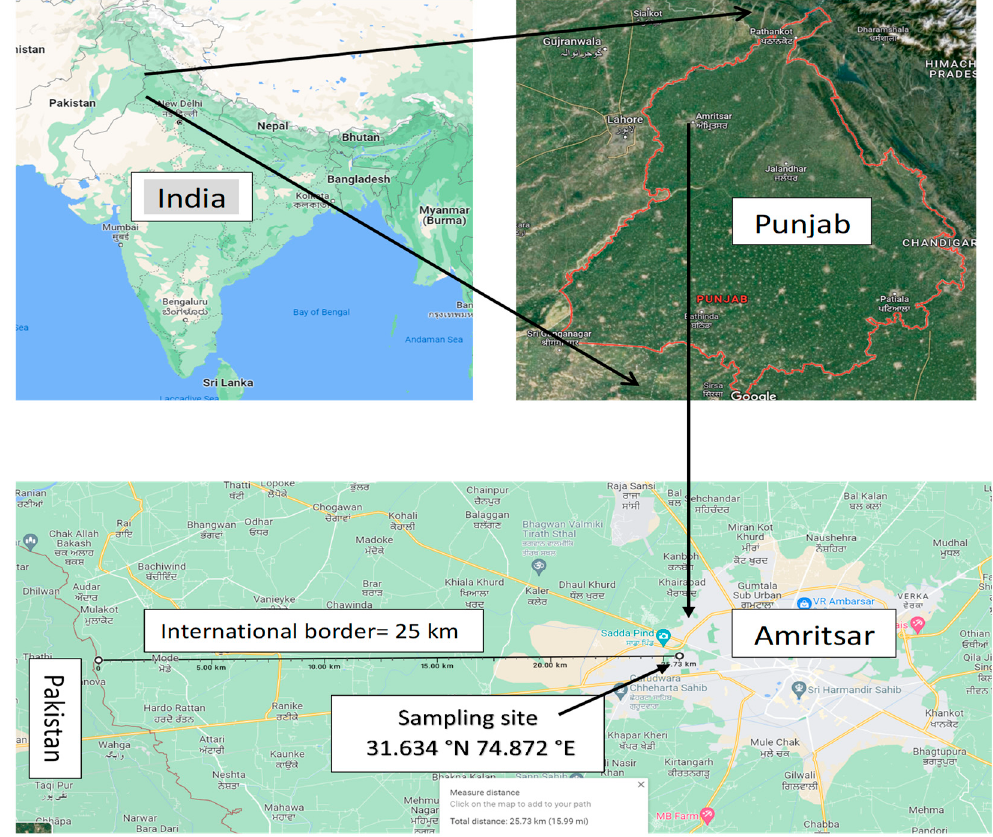
Figure 1. Sampling site in Amritsar city .